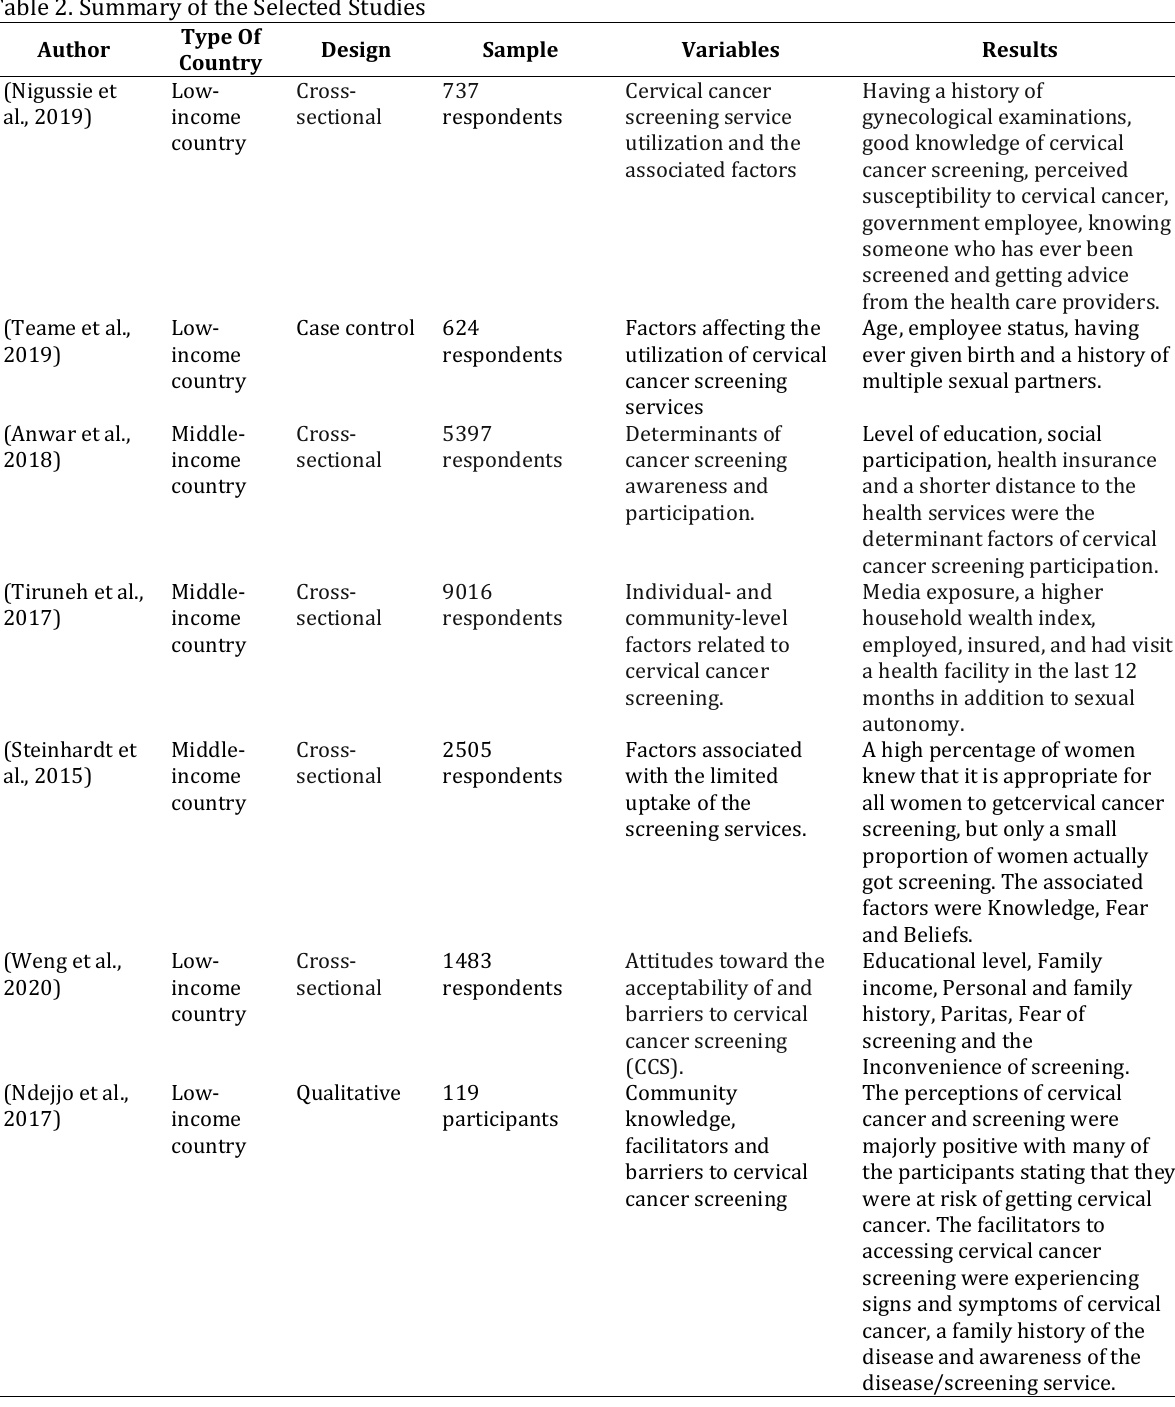
Table 2. Summary of the Selected